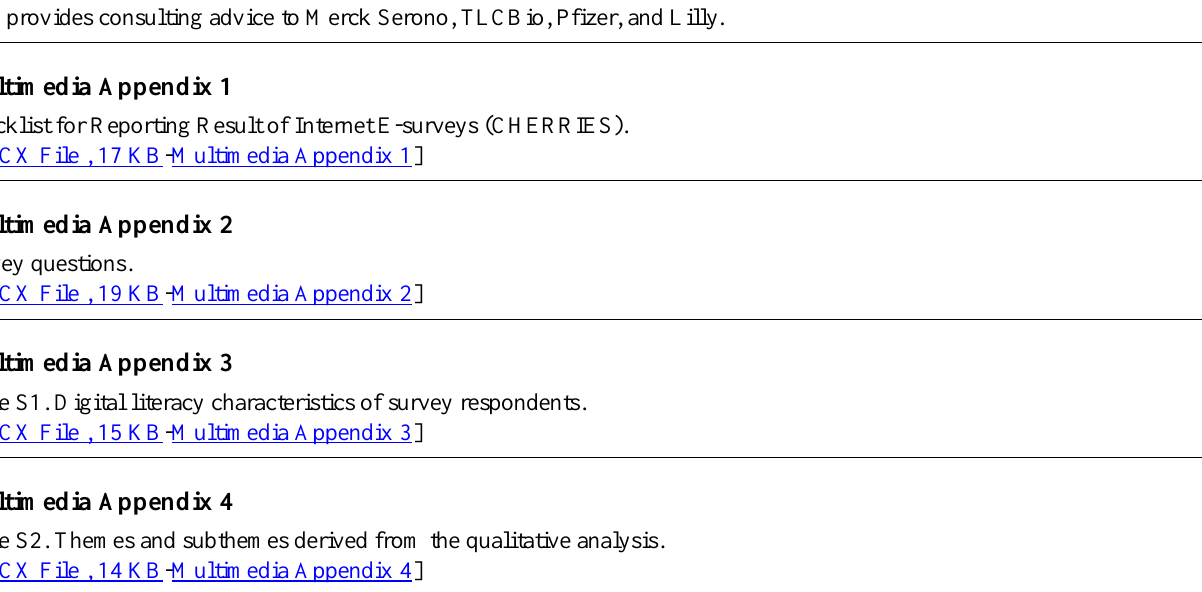
Table S2. Themes and subthemes derived from the qualitative